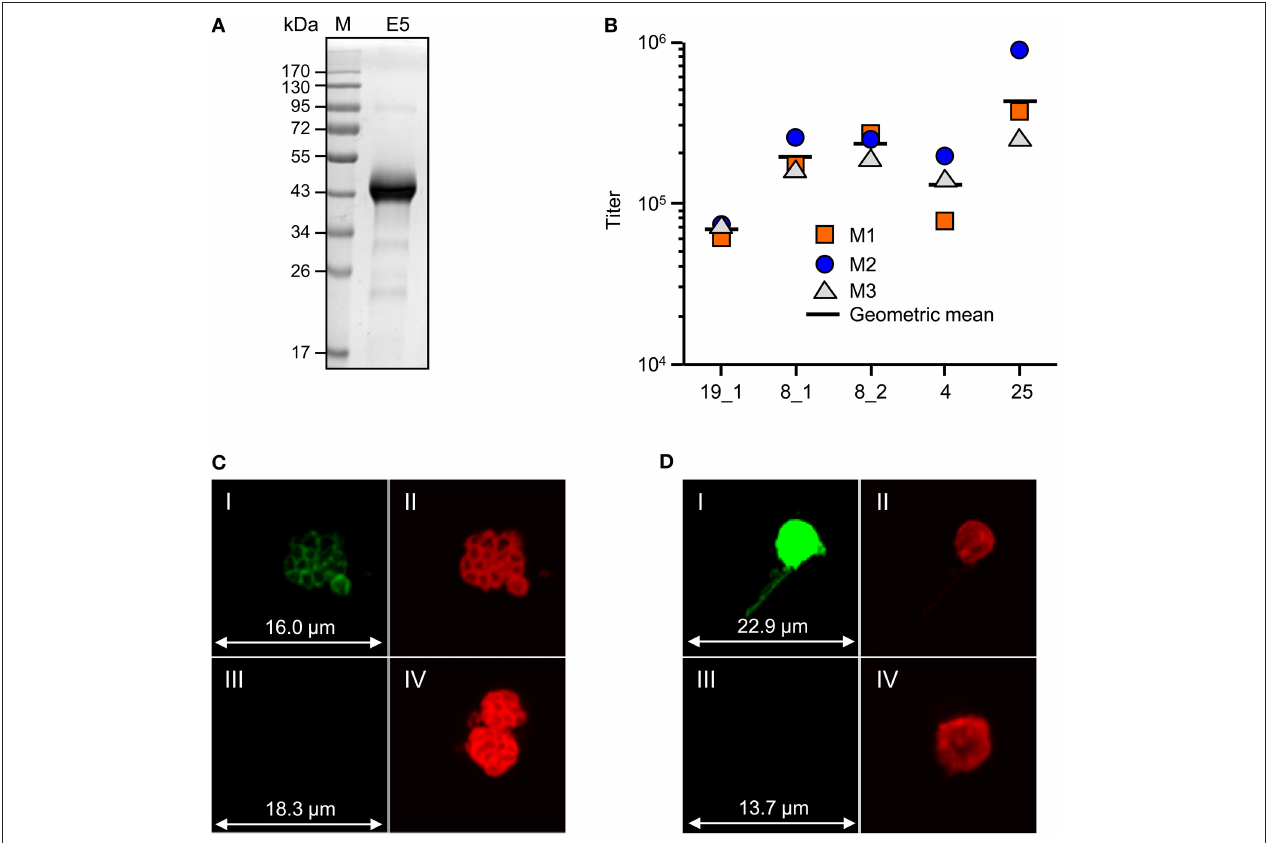
FIGURE 8 | Initial characterization of E5-specific immune responses. (A) SDS-PAGE analysis of purified E5. M, PageRuler TM pre-stained protein ladder (Fermentas); E5, 15 µ g of purified E5 under reducing conditions. (B) Domain-specific titer analysis of E5-specific murine immune sera. Titers were derived by direct-coating ELISA against purified single-domain RFP-fusions (data not shown) and are defined as the dilution that gives more than twice the value of pre-immune serum. Titers for the individual animals are given (M1–M3) as well as the geometric mean (horizontal solid black line). For domain identification refer to Table 1 . (C,D) Immunofluorescence assay of P. falciparum NF54 parasites at two different stages. (C) Schizonts (blood stage) and (D) macrogametes (sexual stage) were fixed with methanol on the surface of a slide. Detection with IgGs from mice immunized with E5 is shown as a representative example. Rabbit antisera, Pf Msp1-19 (schizonts) and Pfs 25 (magrogametes) were used as positive controls. Rabbit controls were visualized with an anti-rabbit secondary antibody labeled with Alexa Fluor 594 (red) whereas murine immune IgG was visualized with a secondary Alexa Fluor 488 labeled anti-murine antibody (green). (I) murine immune IgG; (II) counterstaining with stage-specific rabbit antiserum; (III) neutral mouse serum; (IV) counterstaining with stage-specific rabbit